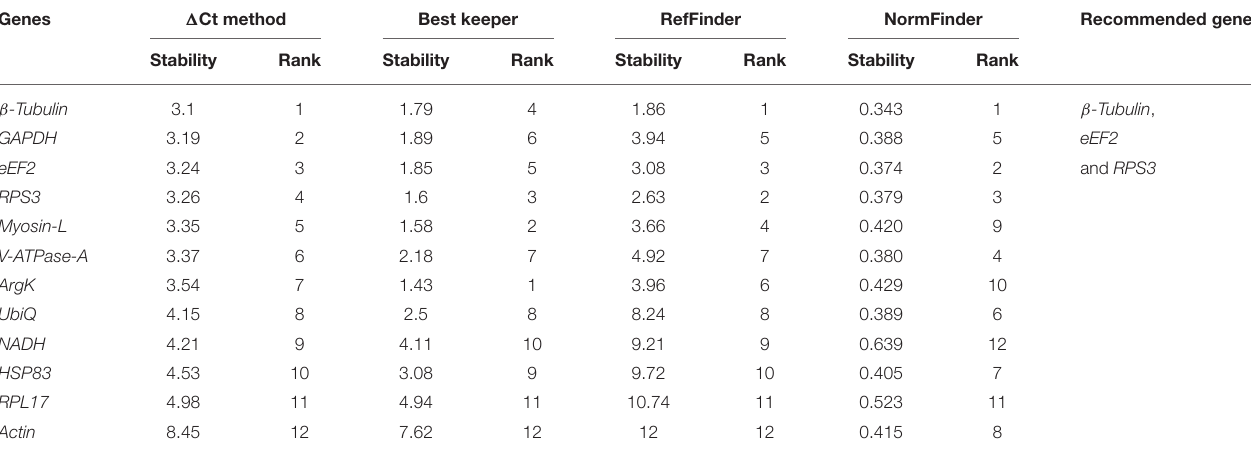
TABLE 2 | Ranking of the candidate reference genes based on stability values performed by Delta Ct, BestKeeper, RefFinder, and NormFinder, in different developmental stages [i.e., larval stages (L1, L2, and L3), pupae (P), callow (newly emerged) male (CM), and female (CF)] and fed adult (mature adults move toward trunks of pines to lay eggs for next-generation) male (AMF) and female (AFF).